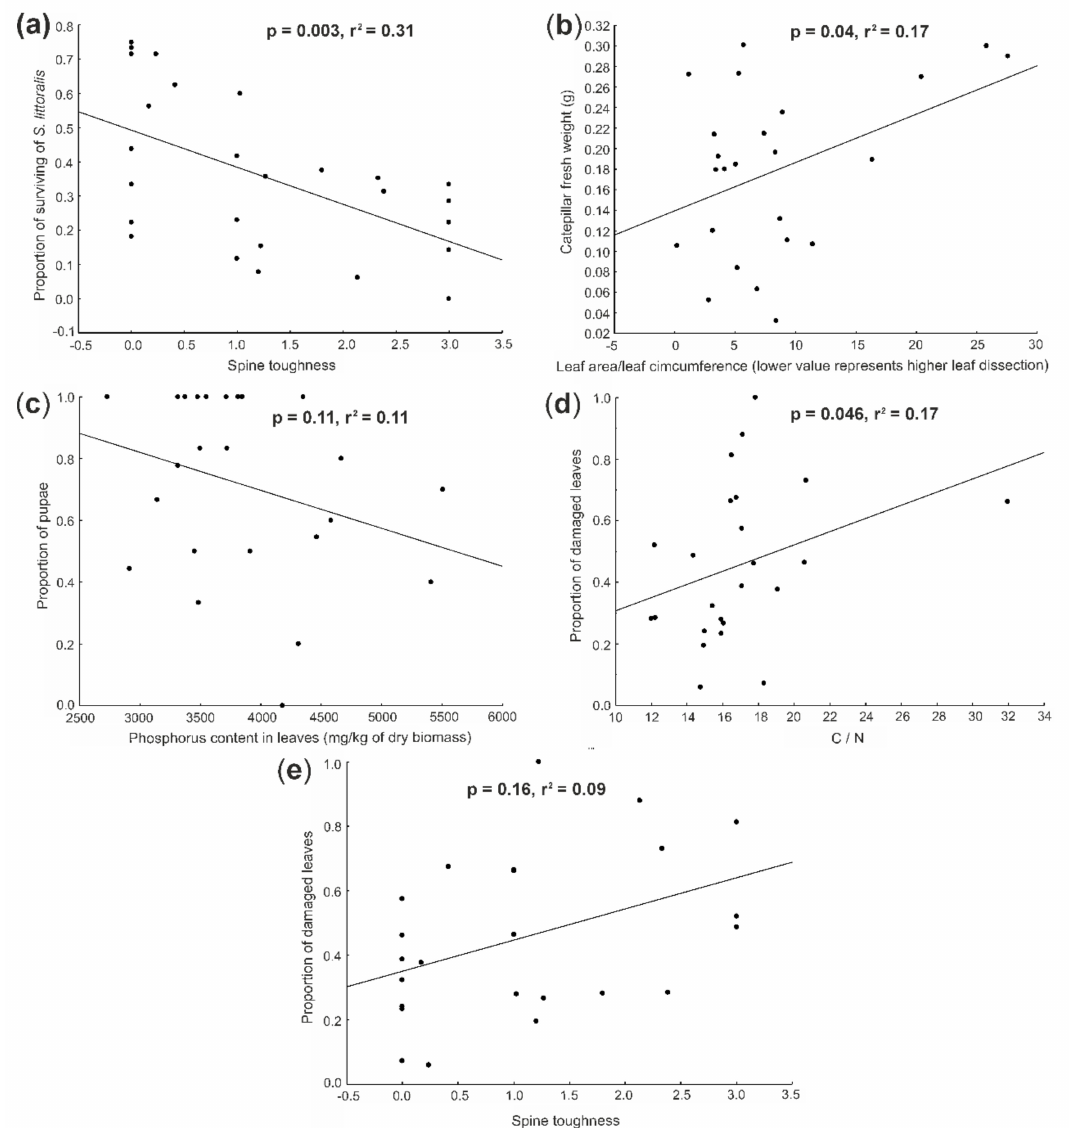
Figure 1. E ff ect of ( a ) spine toughness on the proportion S. littoralis surviving on each tested plant species, ( b ) leaf dissection on S. littoralis fresh weight, ( c ) phosphorus content in the leaves on proportion of pupae, ( d ) carbon to nitrogen (C:N) ratio on proportion of damaged leaves and ( e ) spine toughness on proportion of damaged leaves. The figures show all the significant relationships identified in Table 2, which were retained in the final models based on the step-wise selection procedure (marked S in Table 2, except for the composite trait). The datapoints represent means of the predictor and response variables for each species. The significance values are shown in the